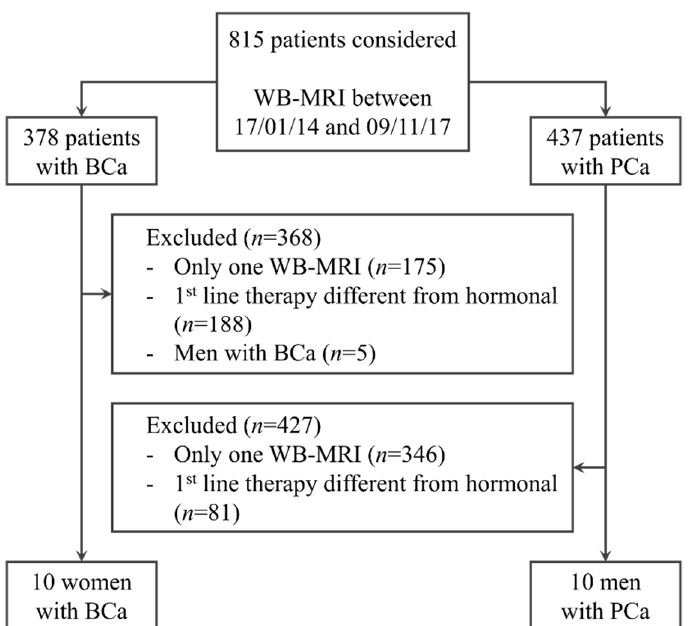
Figure 3. Diagram of the patient selection workflow. Of the 815 patients who had undergone whole-body MRI (WB-MRI) in our institution during the study period, 20 patients, 10 men with prostate cancer (PCa) and 10 women with breast cancer (BCa), satisfied the inclusion criteria of having undergone more than one WB-MRI, and being on first-line hormonal therapy.